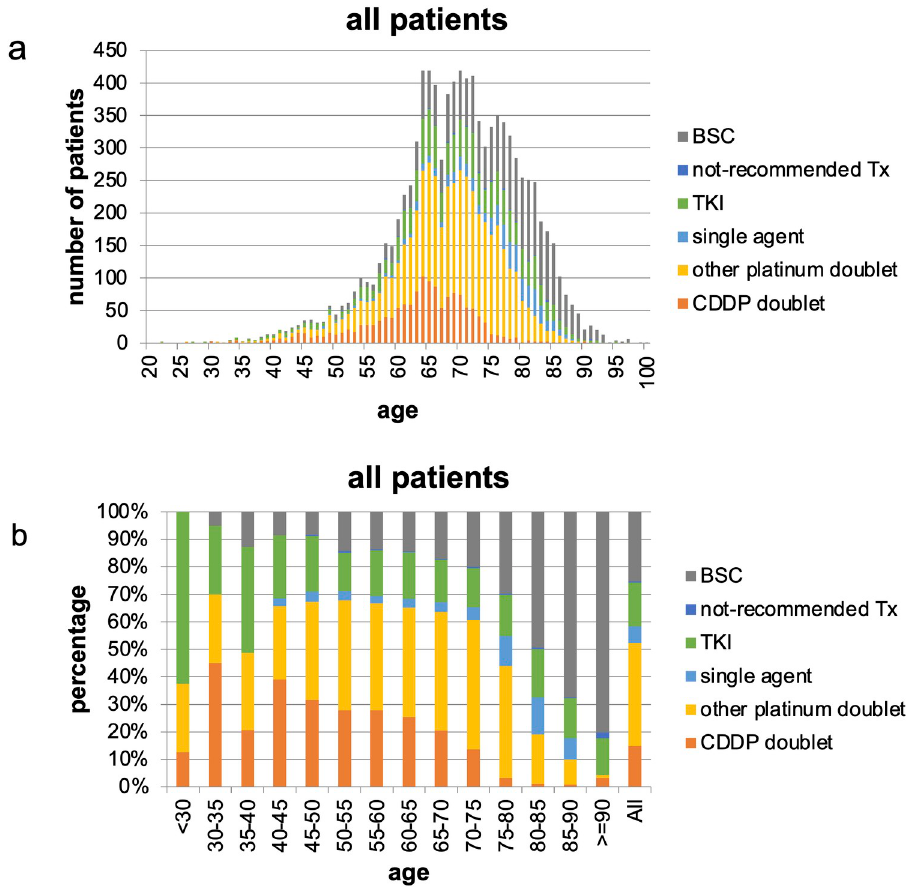
Fig 2. First-line treatment choice in all patients. (a) number of patients and (b) percentage of patients. CDDP, cisplatin; TKI, tyrosine kinase inhibitor; not-recommended Tx, not-recommended chemotherapy; BSC, best supportive